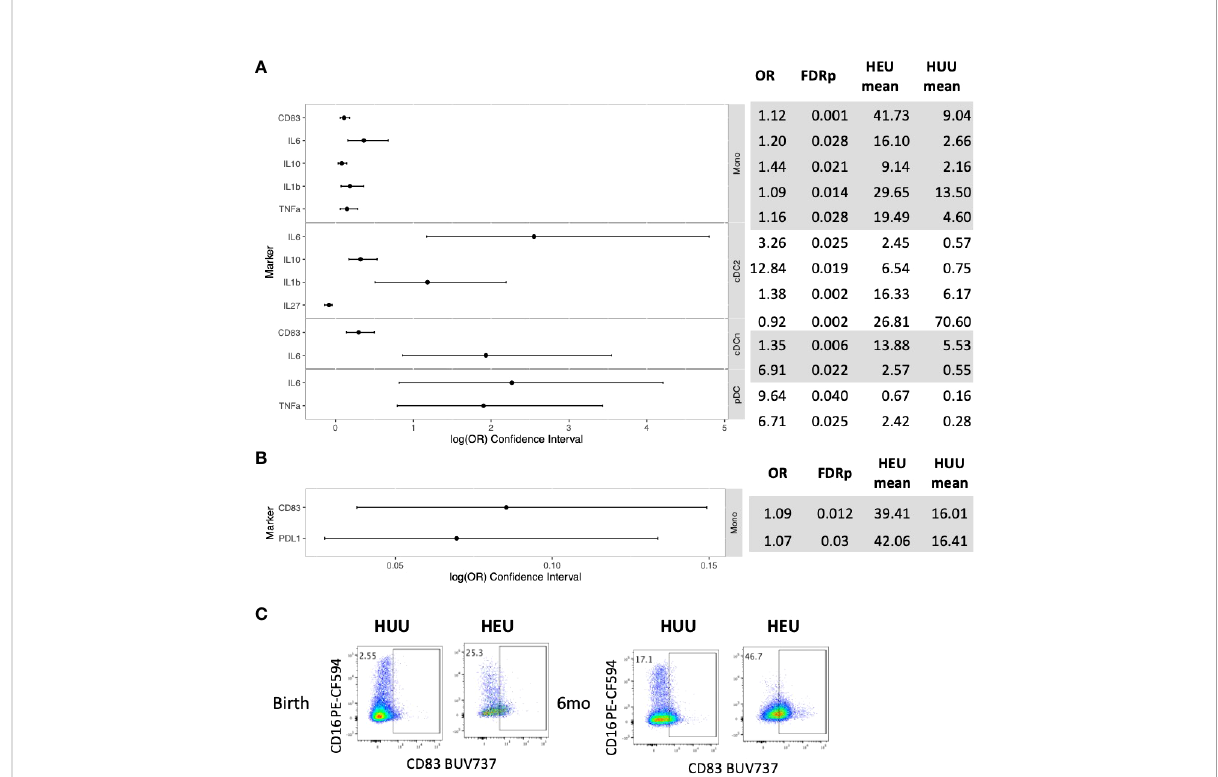
FIGURE 1 Differential phenotypic characteristics of APC in HEU and HUU at birth and 6 months of life. Data were derived from 24 HEU at birth, 28 HEU at 6 months, 64 HUU at birth and 45 HUU at 6 months. (A) Forest plot and summary statistics of signi fi cant differences in HEU and HUU at birth (OR, odds ratio; FDRp, p values after FDR correction; mean, mean proportion of cells expressing the marker of interest in unstimulated conditions). (B) Forest plot and summary statistics of signi fi cant differences in HEU and HUU at 6 months of life. (C) Representative scatter plots of CD83+ Mono (Lin-HLADR+CD14+) illustrating phenotypic (unstimulated conditions) differences between HEU and HUU at birth and 6 months of life in unstimulated